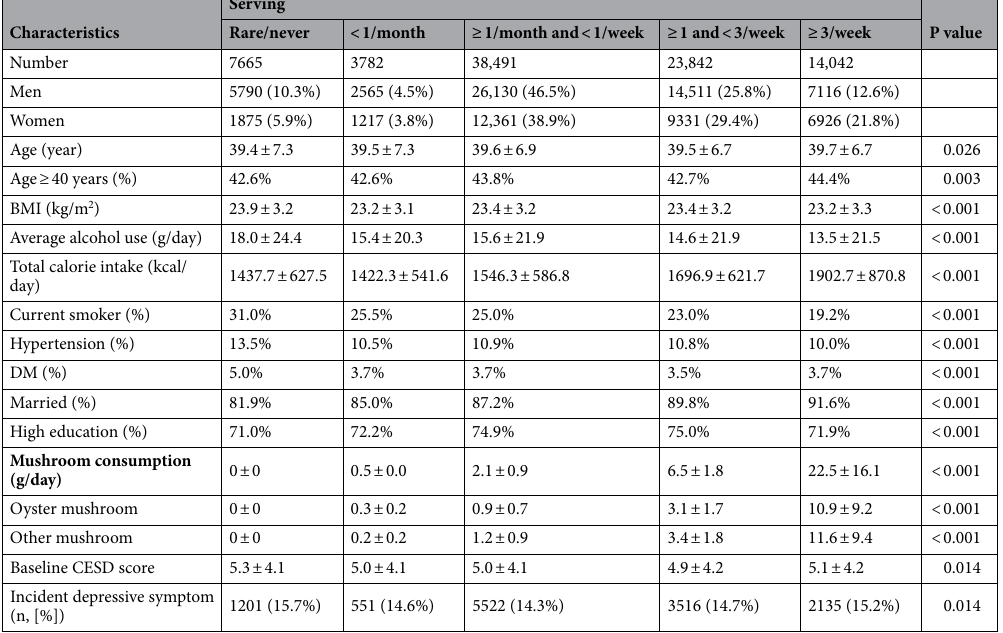
Table 1. Baseline clinical characteristics of study participants according to the mushroom consumption. Continuous variables are expressed as mean (± SD), and categorical variables are expressed as number (percentage (%)). < 1/month < 1 serving size/month, 1/month–1/week 1 serving size/month ≤ and < 1 serving size/week, 1–3/week 1 serving size/week ≤ and < 3 serving sizes/week, ≥ 3/week ≥ 3 serving sizes/week. BMI body mass index, DM diabetes mellitus, CESD Center for Epidemiologic Studies